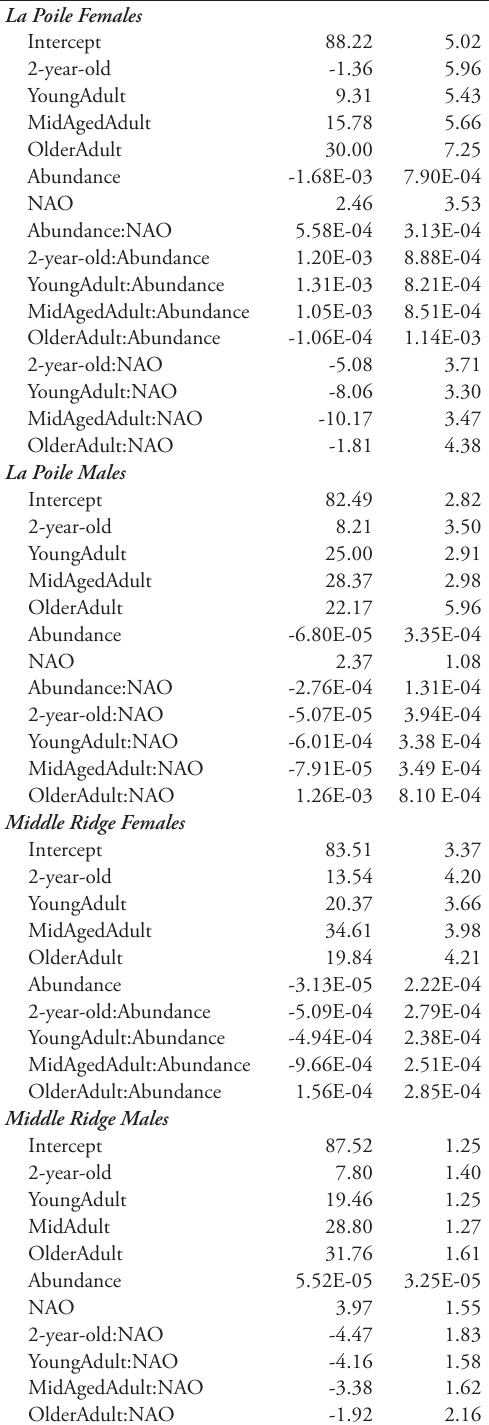
Parameter Estimate SE La Poile Females Intercept 88.22